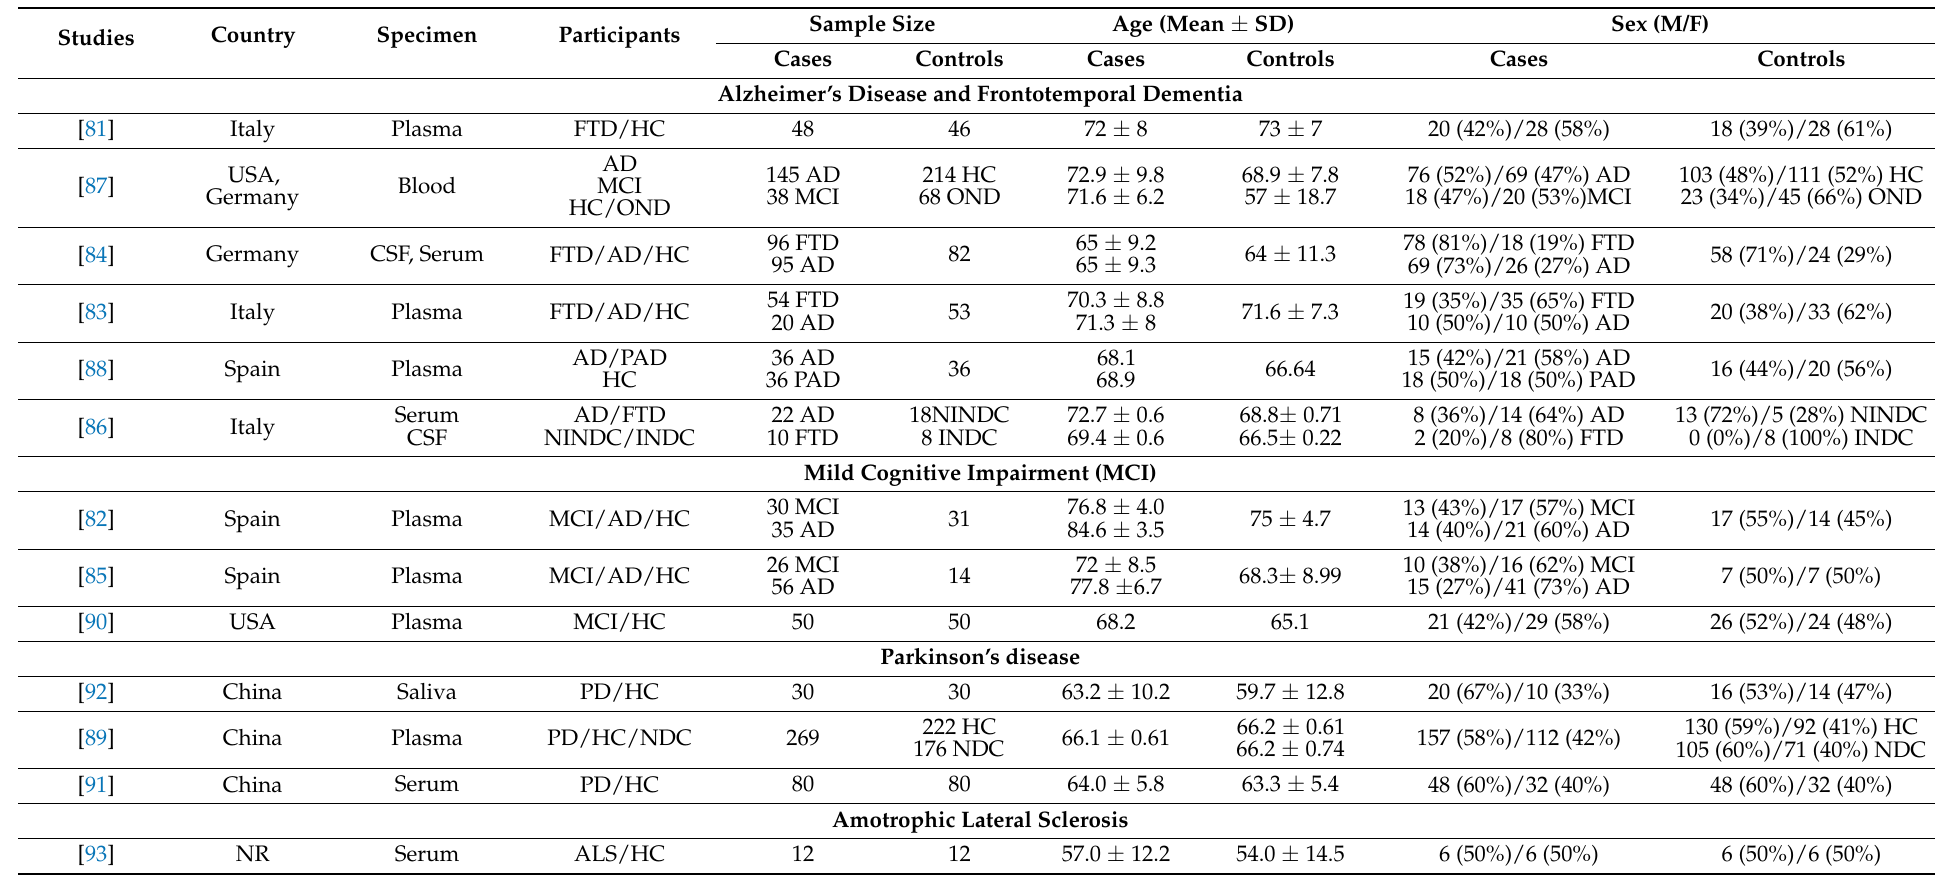
Table 1. Main features of studies included in the